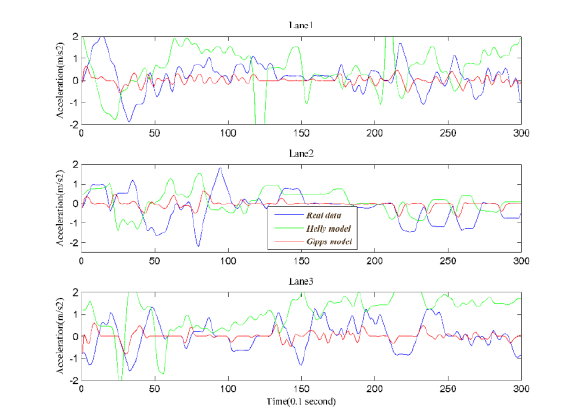
Figure 6. Difference between the real data and two conventional model (Helly and Gipps)